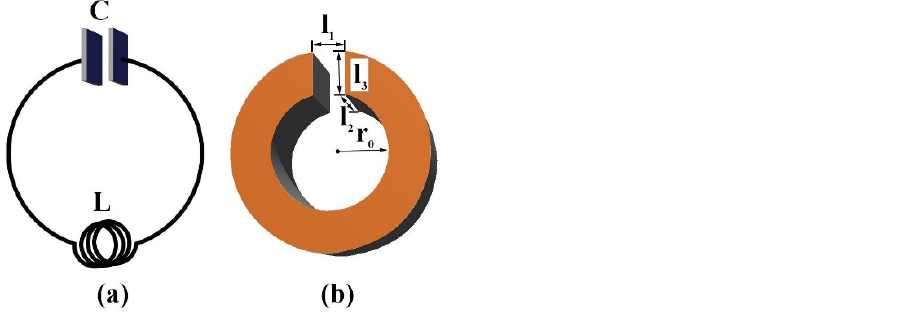
Figure 2. Schematics of the analogy. ( a ) A usual LC circuit (with effective inductance L and the capacitance C ). ( b ) SRR (with the gap size l 1 , the thickness l 2 , the width l 3 , and the radius r 0